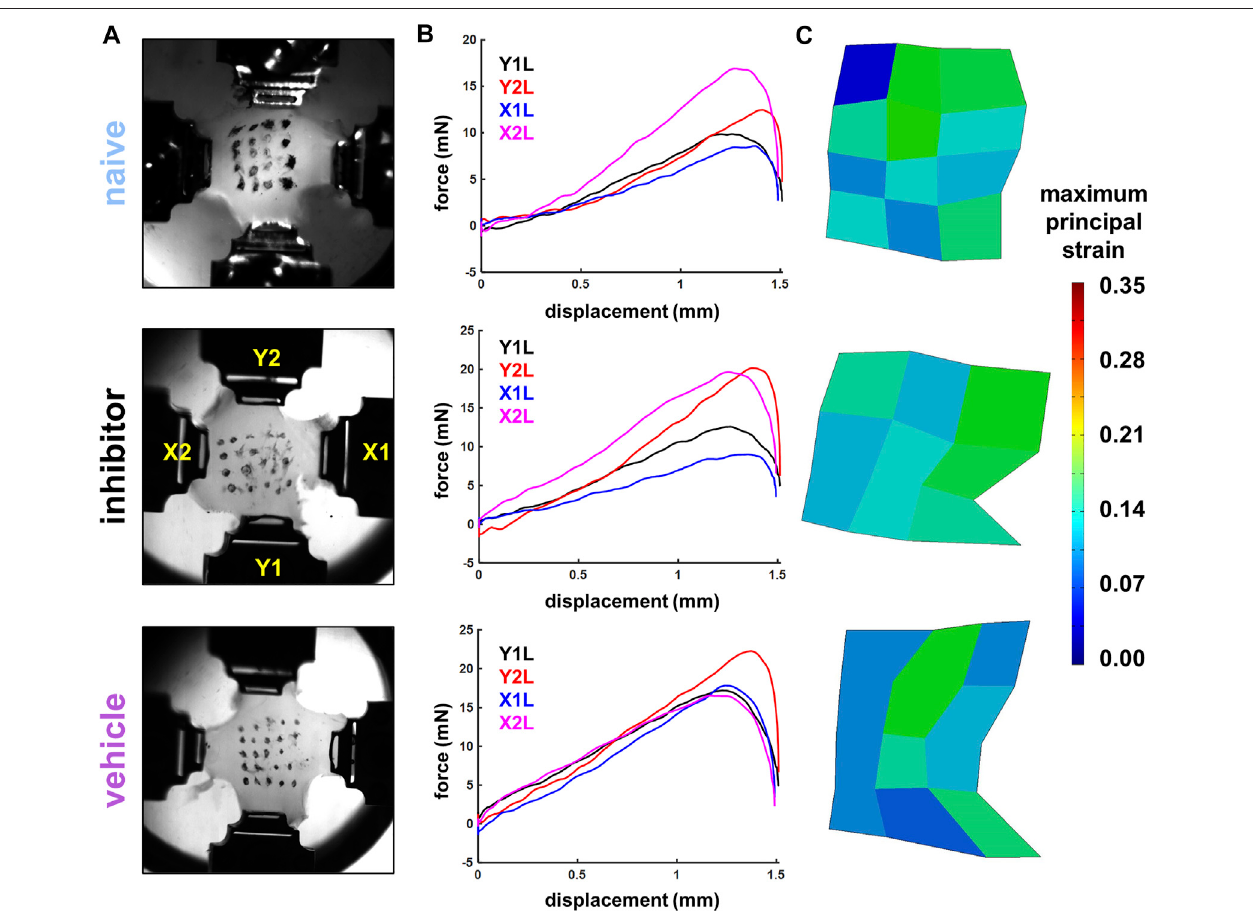
FIGURE 2 | Exemplary high-speed images (A) , force-displacement curves (B) , and maximum principal strain surface maps (C) from stretched co-culture gels showinggelsfromthenaïve(gelS18),inhibitor (gelS72),andvehicle(gelS54)groups.Imagestillsin (A) showgelsaf fi xedinfouractuator gripsintheimagestillcaptured immediatelybeforethepeak forcewasachieved, which wasidenti fi ed asthemaximummagnitude offorce during agel stretchrecordedbyany ofthefour loadcells (B) . Strain maps in (C) show that a 1.5 mm/arm equibiaxial stretch imposes similar average (S18: 9.21%; S72: 10.79%; S54: 9.21%) and maximum surface principal strains (S18: 17.35%; S72: 17.26%; S54: 18.09%) across the